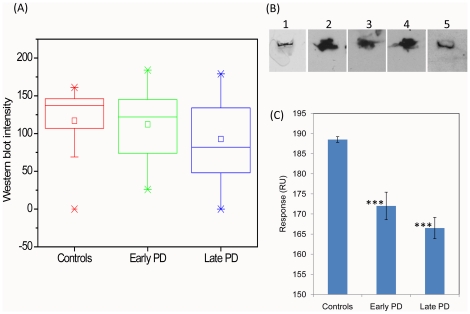
Immune responses towards amyloid fibrils of α-synuclein in the blood sera of controls, early and late PD patients.(A) Box-plots showing statistical distributions of immune responses measured by Western blotting. The descriptions of box-plots are the same as in Figure 2B. (B) Representative native gel band corresponding to amyloid fibrils (1) and Western blots bands showing interactions of α-synuclein fibrils with anti-fibrillar antibodies (2), with sera IgGs from selected control (3) as well as early PD (4) and late PD (5) individuals. (C) Biacore analysis of the interactions with amyloid fibrils of pooled IgGs from the blood sera of controls, early and late PD patients. Surface plasmon resonance responses in relative units are shown in y-axis. ***P<0.0001.